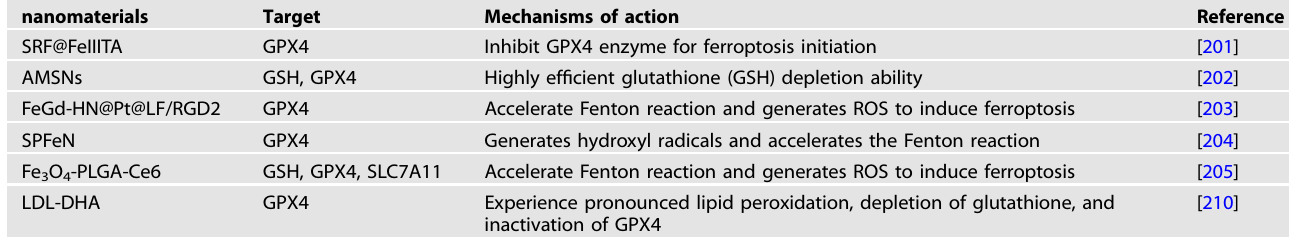
Table 5. The applications of nanomaterials in targeting tumor